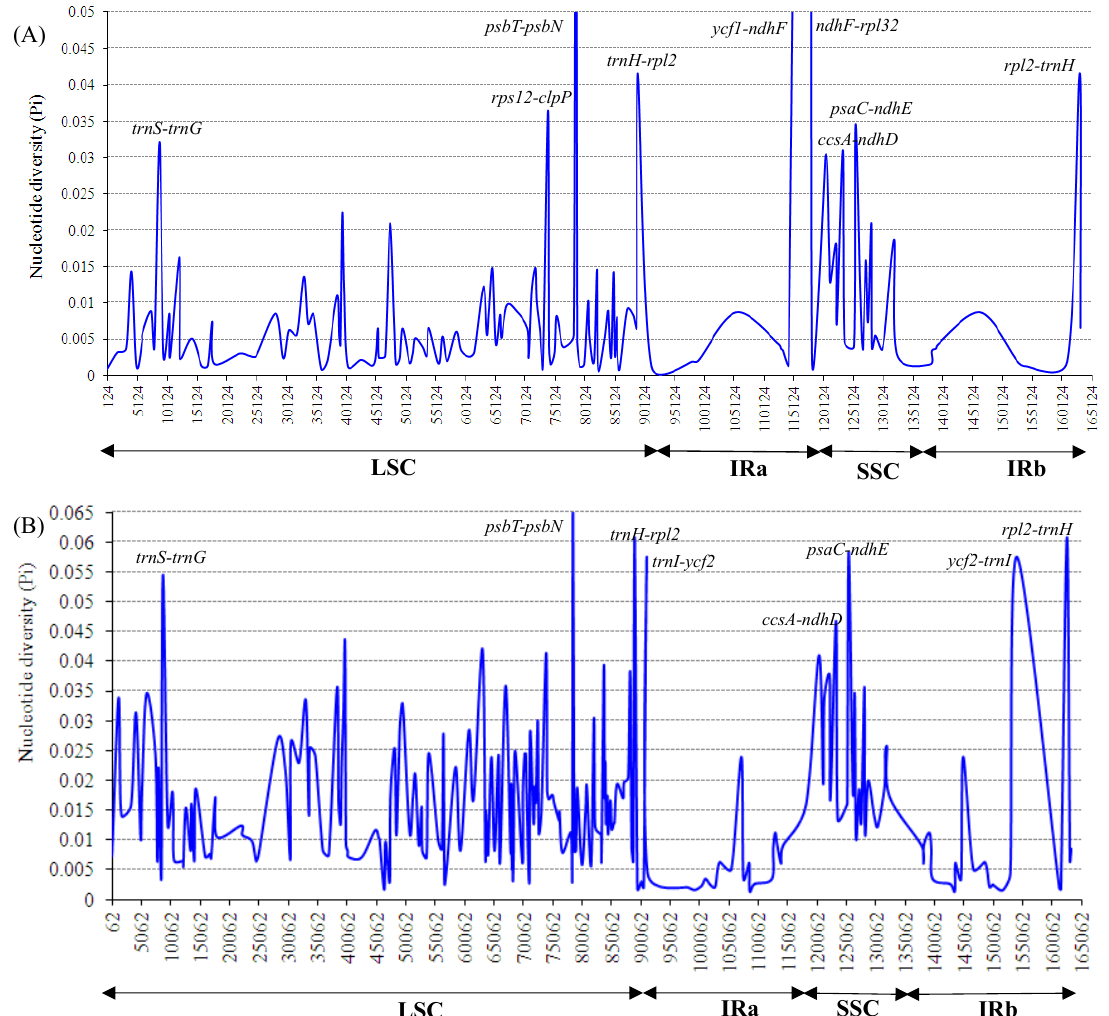
Figure 7. Sliding window analysis of the whole chloroplast genomes. Window length: 800 bp; step size: 200 bp. X -axis:position of the midpoint of a window. Y -axis: nucleotide diversity of each window. ( A ) Pi between K. galanga and K. elegans . ( B ) Pi among two Kaempferia species, Alpinia zerumbet ,